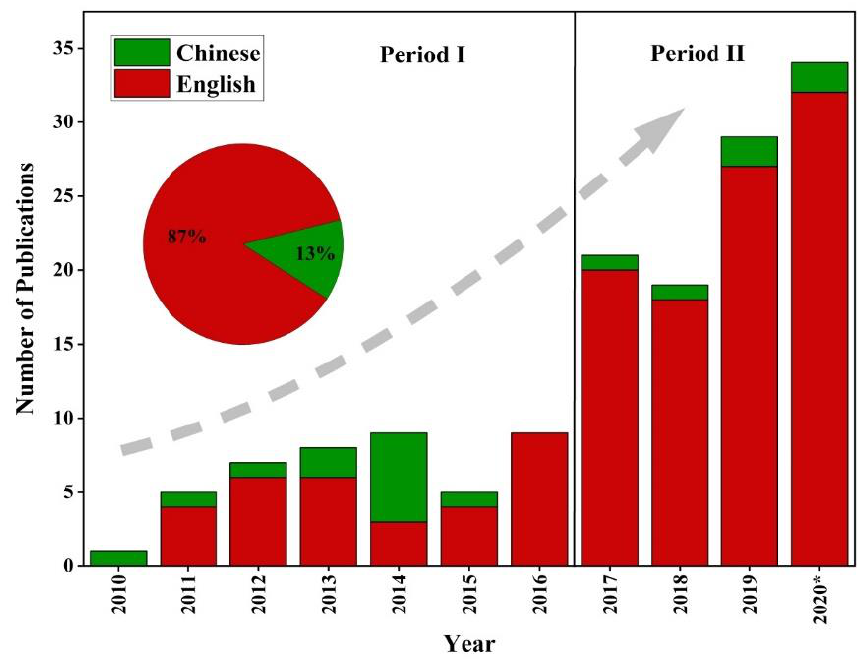
Figure 1. Number of publications on SCCPs in China per year during the period 2010–2020. (Inset) Percentages of publications in English and Chinese. (*) The number of publications in 2020 was estimated based on the count in the first 6 months.